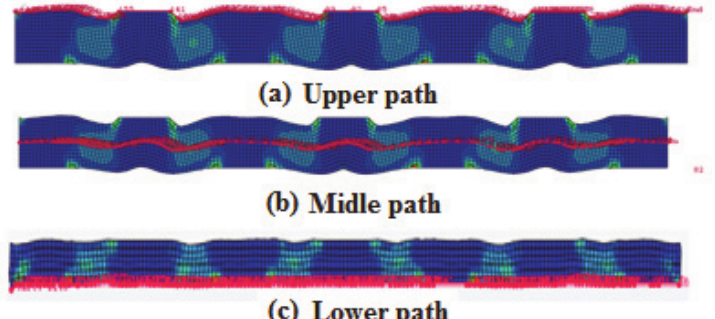
Figure 6: Different paths selected for